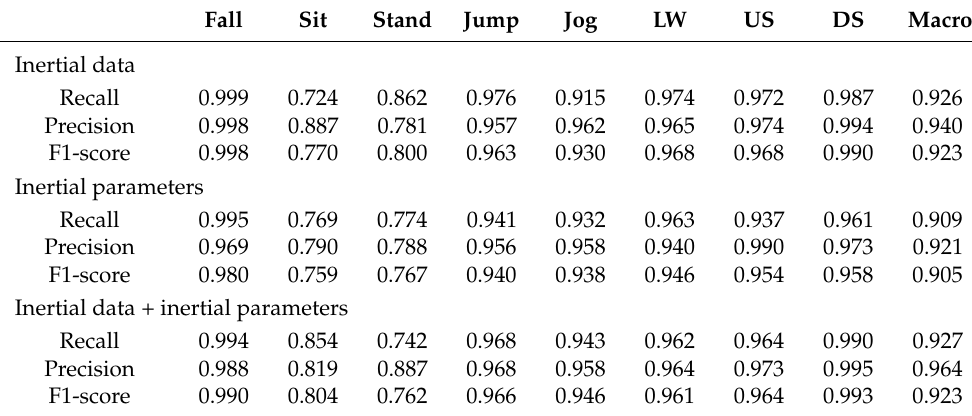
Table 5. Results on the detections of fall and physical activities based on inertial data and parameters obtained from both feet. Fall Sit Stand Jump Jog LW US DS Macro